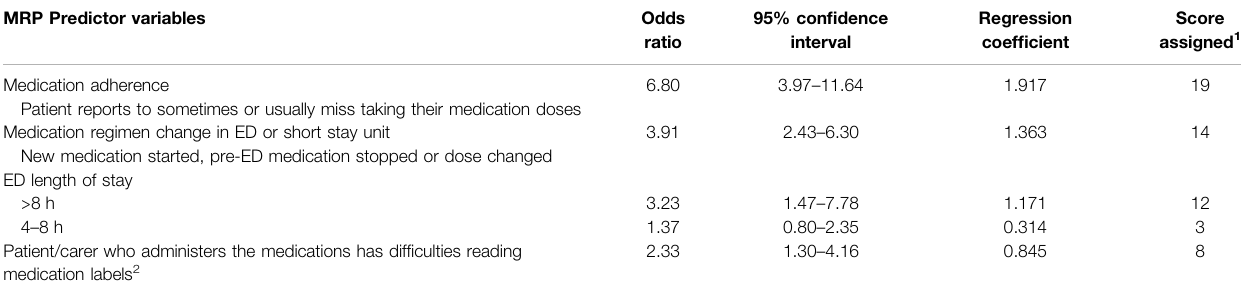
TABLE 3 | ED Discharge Screening Tool: summary of multivariable regression analysis of predictor variables for medication-related problems that could be identi fi ed/ managed/prevented by screening at the time of ED discharge (n = 616). MRP Predictor